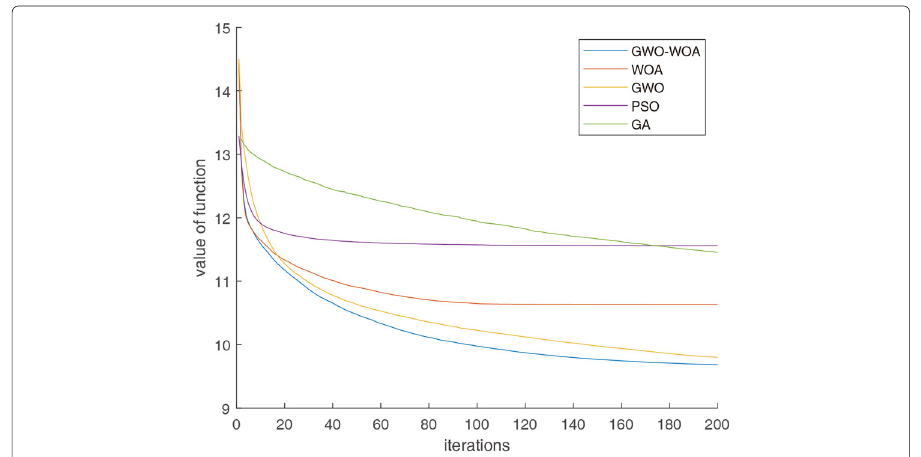
Fig. 5 Convergence curve of algorithms when device number is 120